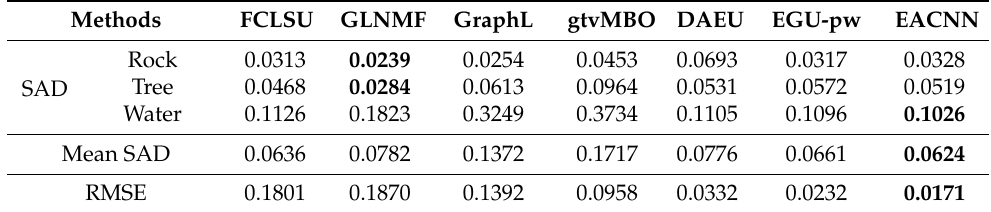
Table 5. Experimental results for the Samson dataset.